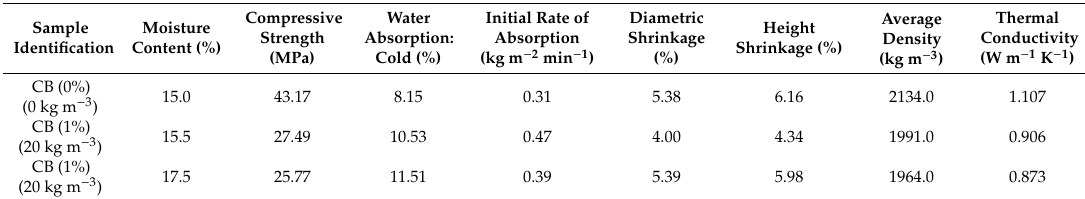
Table 2. Properties of manufactured brick